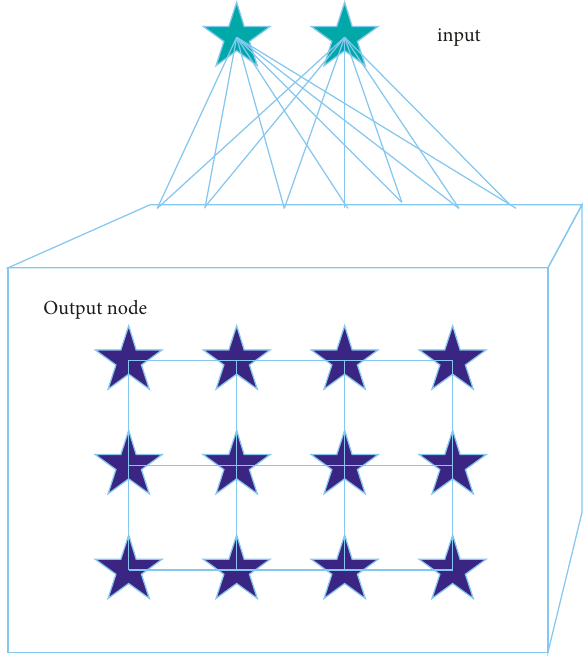
Figure 6: Self-organizing neural